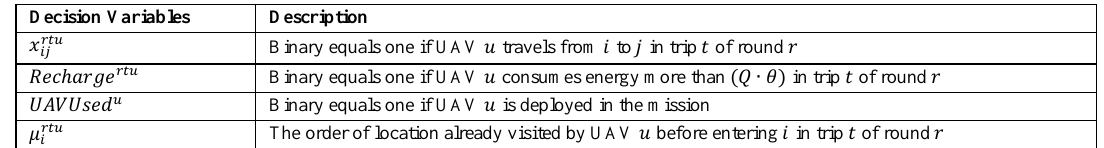
Table 3. Decision